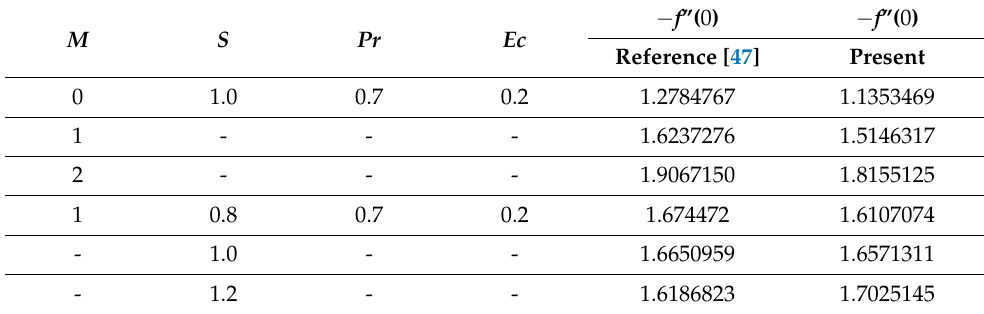
Figure 11. ( a , b ). Impact of various shapes factors of nanoparticles on 𝑓′(𝜂) and 𝜃(𝜂) . Table 5. Impacts of pertinent parameters on Skin fraction coefficient.